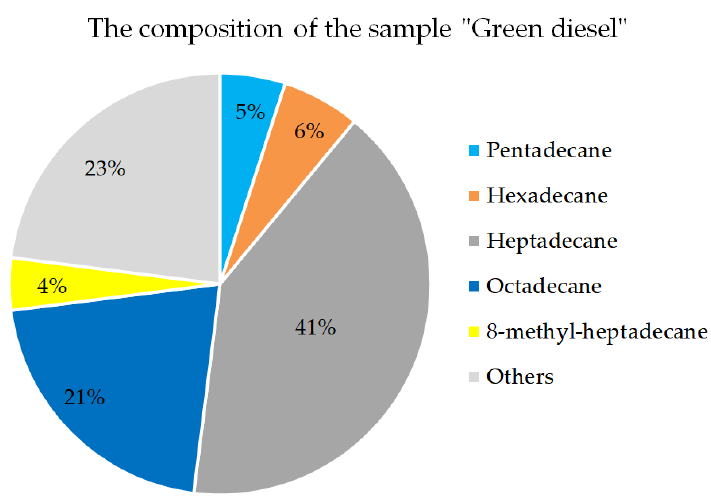
Figure 3. Qualitative and quantitative composition of green diesel.